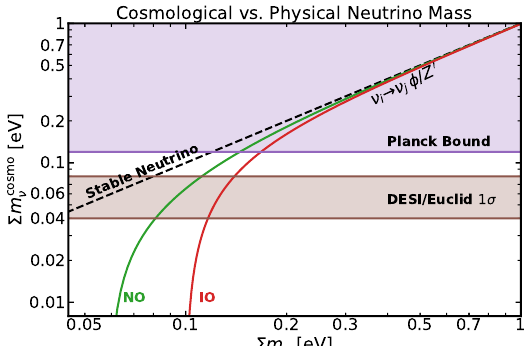
Figure 4 . Estimation for the maximum cosmological neutrino mass bound relaxation induced by ν i → ν j φ/Z 0 decays with τ ν . t U / 10 . The y-axis corresponds to P m cosmo , namely, to the effective ν sum of neutrino masses inferred from the neutrino energy density today Ω ν h 2 ≡ P m cosmo / 93 . 14 eV, ν which corresponds to P m cosmo = 3 m lightest when all neutrinos except the lightest one decay. The ν x-axis is the actual sum of neutrino masses. In brown we highlight the expected sensitivity from DESI / Euclid for stable neutrinos for NO with P m ν = 0 . 06